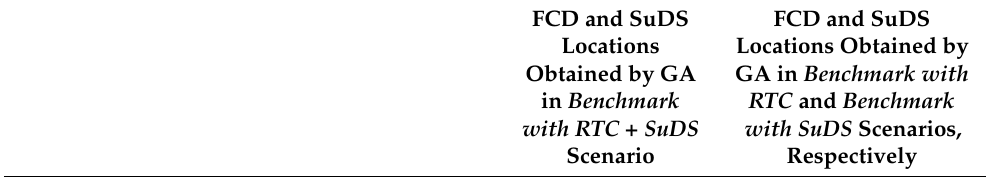
Table 3. Comparison between CSO spill volume reductions obtained by simultaneous and separate optimizations of FCD and SuDS locations within the Arendonk catchment.